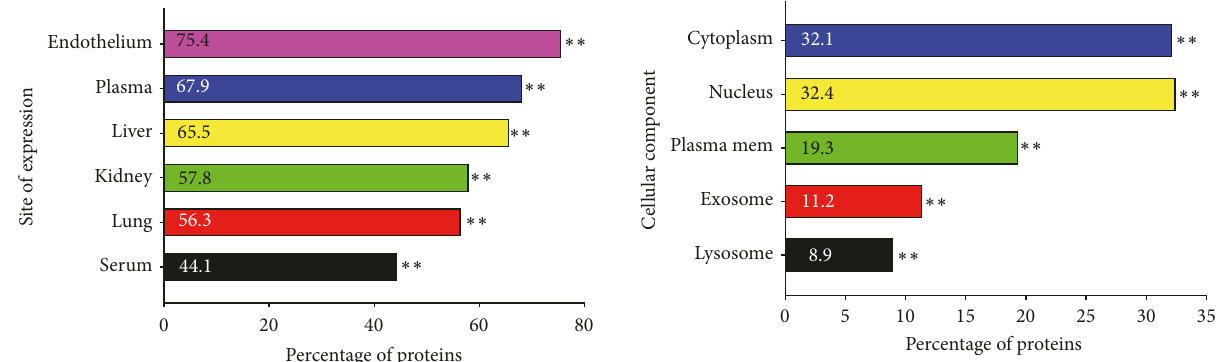
Figure 4: Percentage of proteins found in HIV+ urinary EVs . FunRich analysis of the LC/MS/MS proteins from HIV+ EVs determined the most likely tissue expressing the proteins, site of expression, and the cellular component from which the protein is derived. Data is graphed as the percentage of proteins found. ∗∗ denotes significance, 𝑃 < 0.01 .